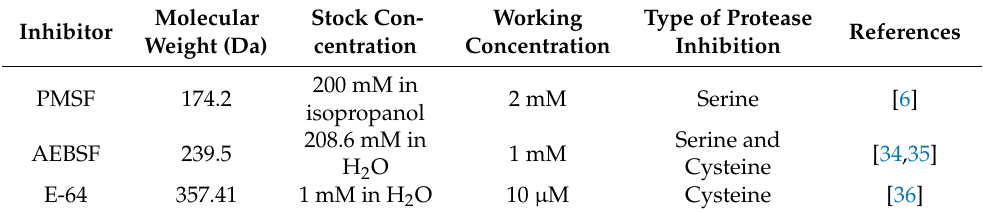
Table 2. Preparation of the stock of protease